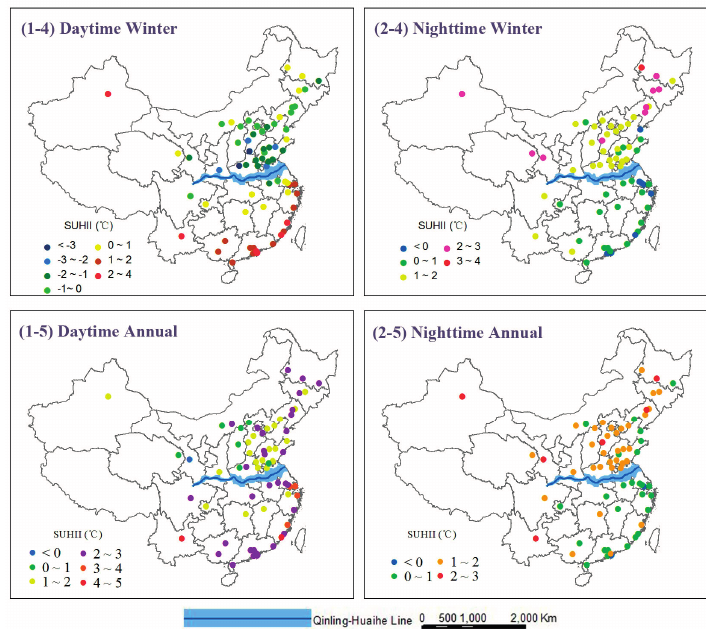
Figure 3. The spatial distribution of the seasonally and annually averaged SUHIIs during day time and night time from 2003 to 2010: ( 1-1 ) Daytime spring; ( 2-1 ) Nighttime Spring; ( 1-2 ) Daytime Summer; ( 2-2 ) Nighttime Summer; ( 1-3 ) Daytime Autumn; ( 2-3 ) Nighttime Autumn; ( 1-4 ) Daytime Winter; ( 2-4 ) Nighttime Winter; ( 1-5 ) Daytime Annual; ( 2-5 ) Nighttime Annual. Table 2. Seasonally averaged values of SUHII and the variances over northern and southern China from 2003 to 2010 (Unit: K). Mean Variance Spring Summer Autumn Winter Spring Summer Autumn Winter Daytime